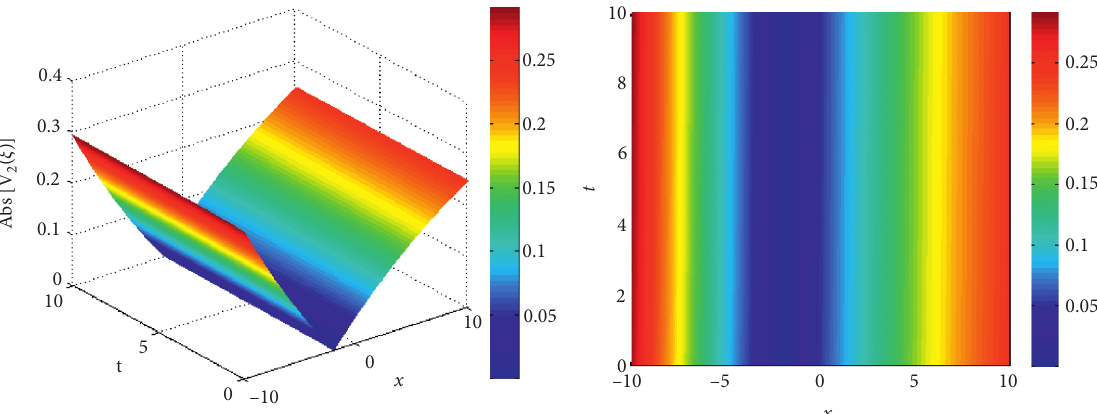
Figure 4: Soliton solutions of equation (34) in 3D and contour plots, where y � 2; v � 0 . 2; a � 2; u � -0.5; k 1 � 2; k 2 � 6; k � 0.02; λ � 4; and α � 0 .